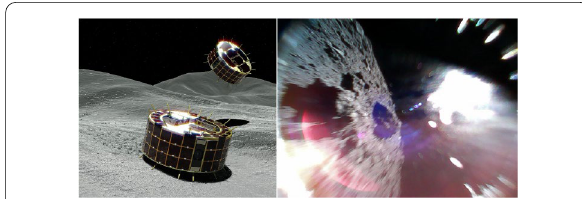
Fig. 1 MINERVA II robot and rendering the contribution. Left: the image of MINERVA II on asteroids. Right: the real photo that the MINERVA II robot took while hopping on asteroid Ryugu